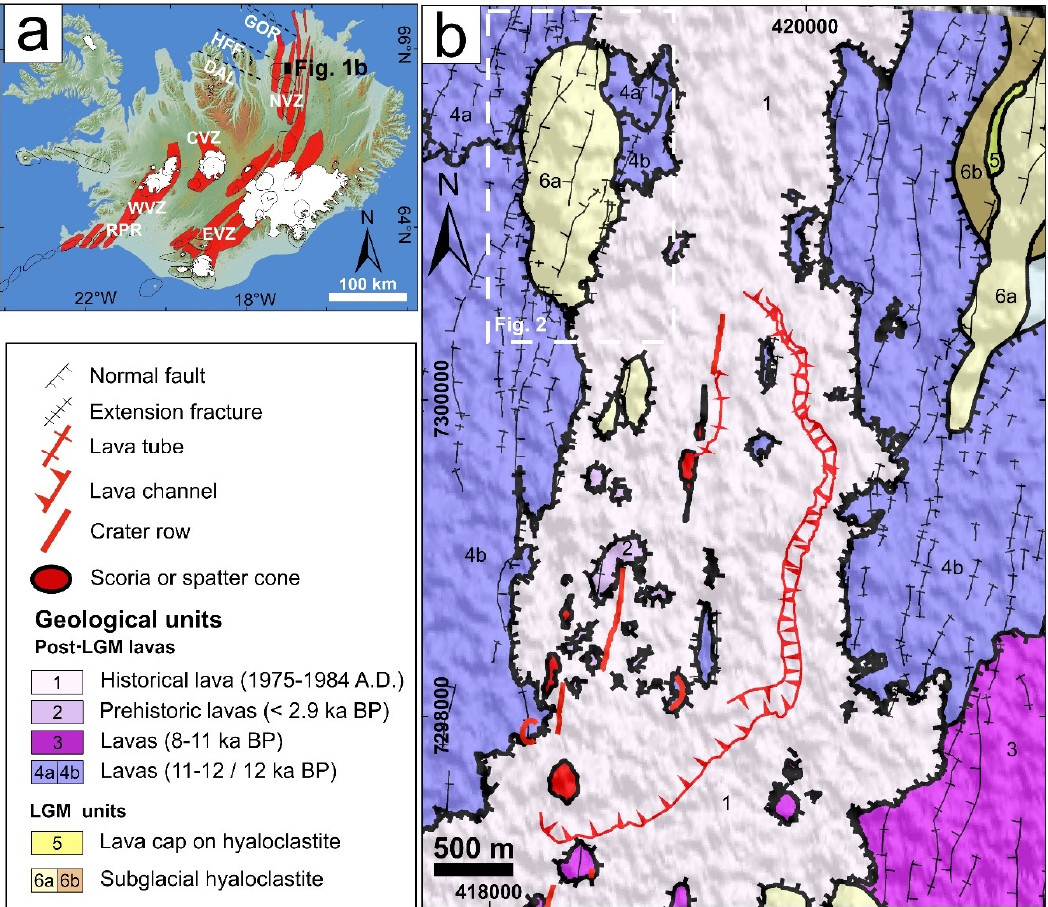
Figure 1. ( a ) Volcanic systems of Iceland (in red), modified after [62]: EVZ = East Volcanic Zone, CVZ = Central Volcanic Zone, NVZ = Northern Volcanic Zone, WVZ = Western Volcanic Zone. Reference system: WGS84, geographic coordinates. ( b ) Geological map of a portion of the KFS where the study area is shown as a dashed white rectangle, based on [39]; LGM = Last Glacial Maximum; reference system: UTM28-WGS84.